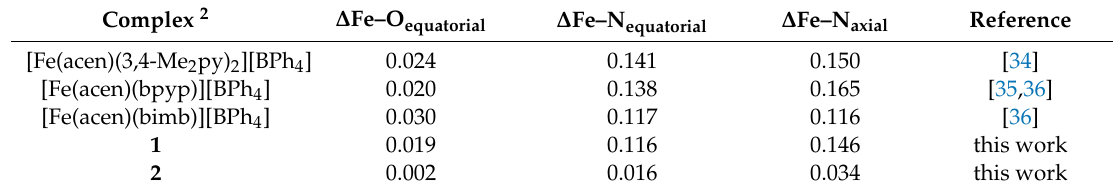
Table 2. Changes of coordination bond distances (Å) 1 between the LS and HS states in 1 , 2 , related complexes.